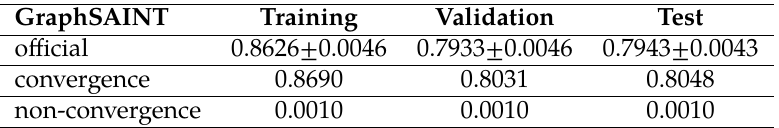
Table 1: Results for the traditional GraphSAINT on the citation dataset of OGB